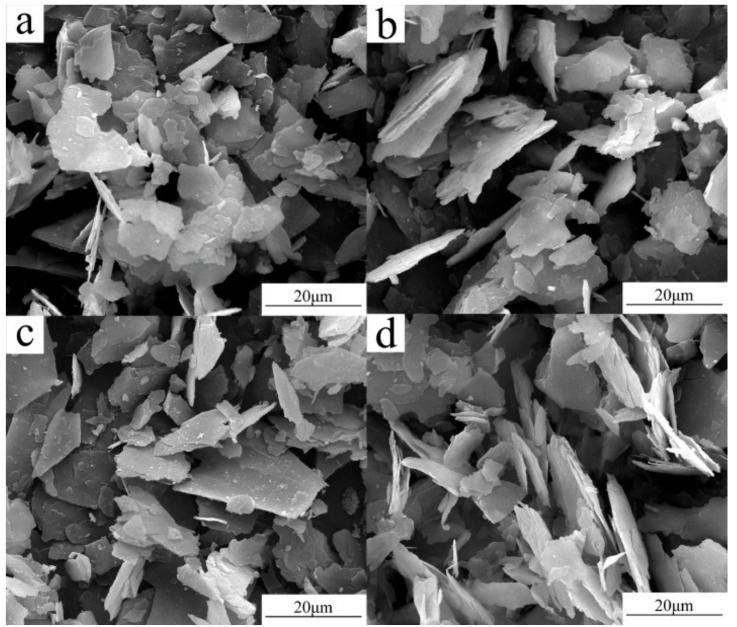
Figure 9. SEM images of ( a ) S 0 ; ( b ) S 1 ; ( c ) S 2 ; and ( d ) S 3